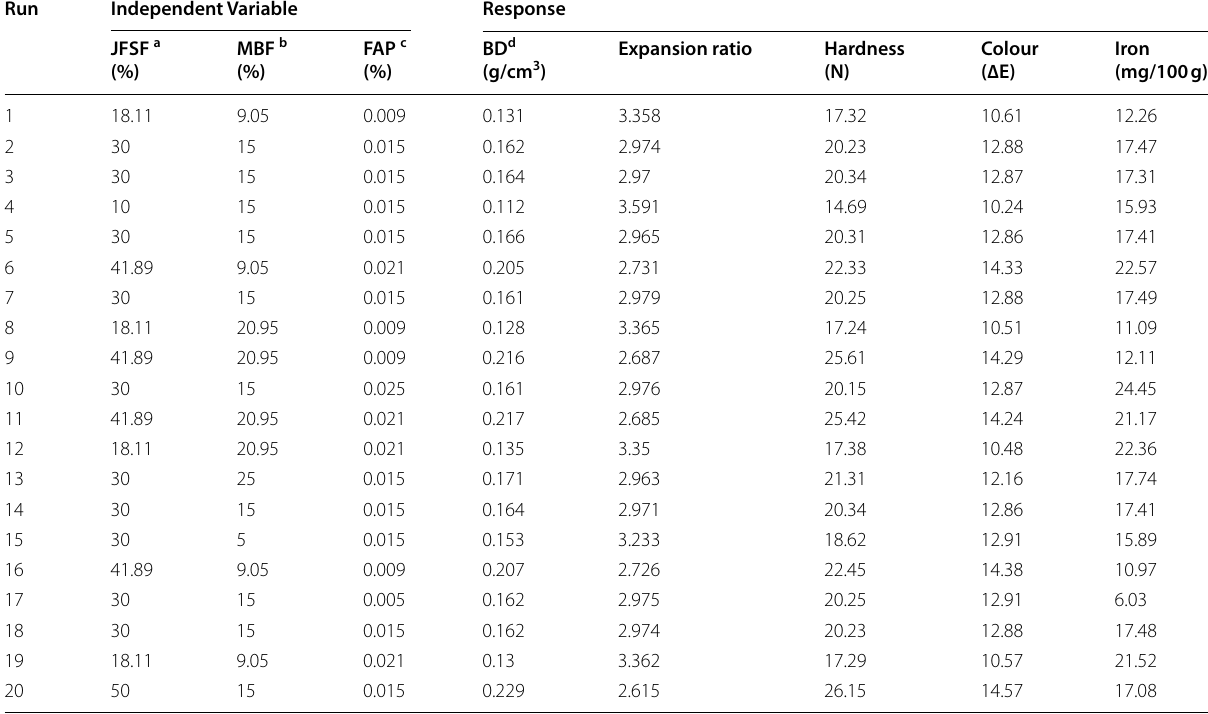
Table 2 Experimental design for iron rich extruded snack with independent variables, experimental and predicted values of